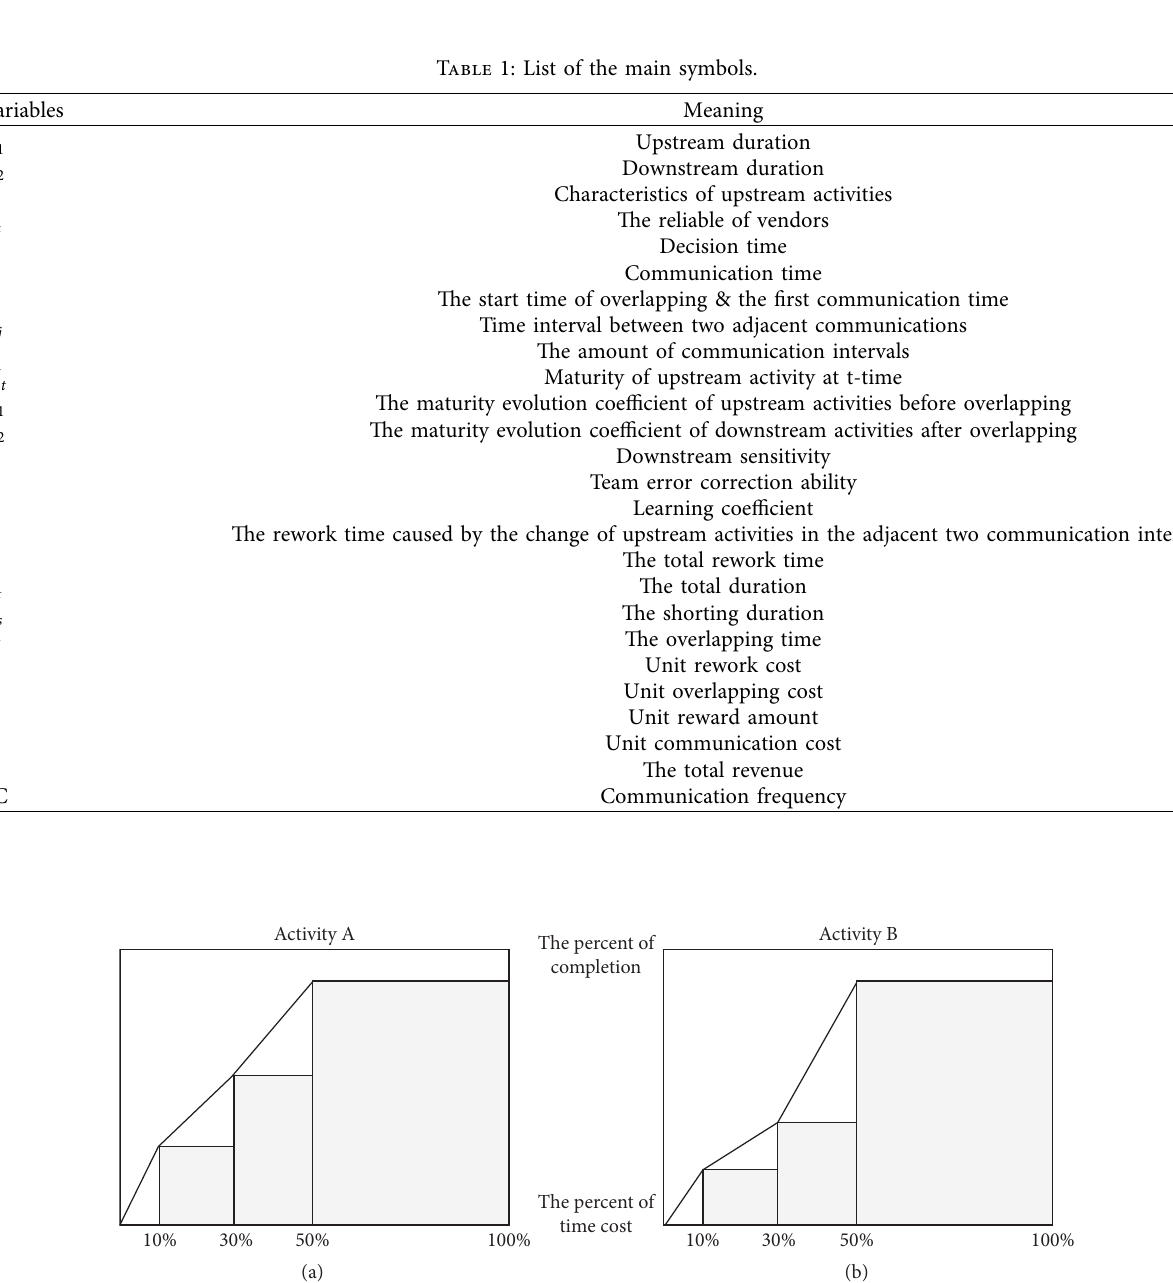
Figure 3: (a) Fast-moving activities in the early stages; (b) fast-moving activities in the late